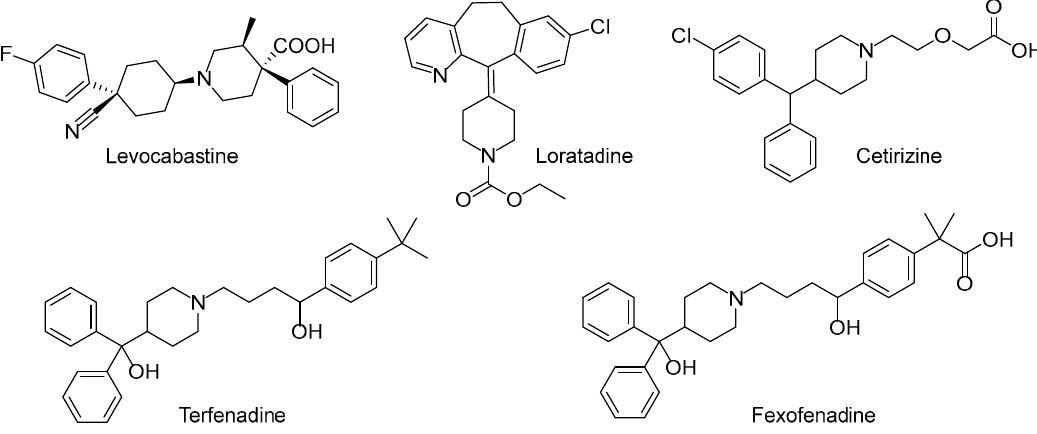
Figure 1. Representative H 1 receptor